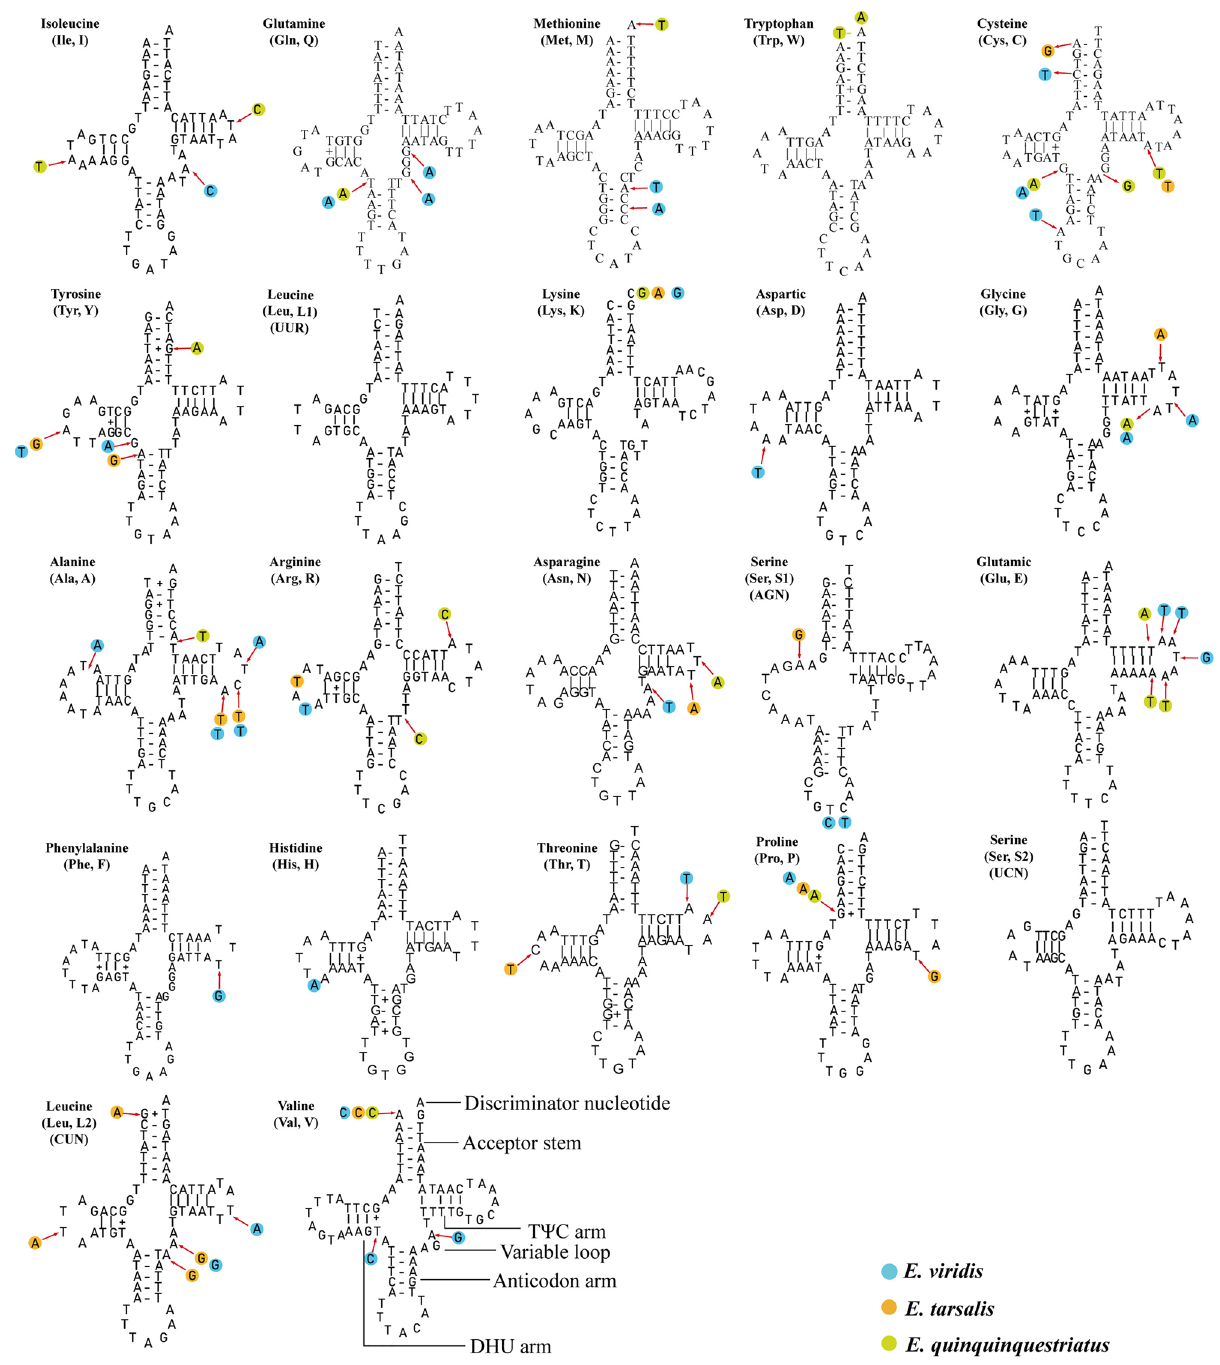
Figure 4. Predicted secondary cloverleaf structure for tRNA of four Eristalinus species. ( A ) Isoleucine, ( B ) Glutamine, ( C ) Methionine, ( D ) Tryptophan, ( E ) Cysteine, ( F ) Tyrosine, ( G , U ) Leucine, ( H ) Lysine, ( I ) Aspartic, ( J ) Glycine, ( K ) Alanine, ( L ) Arginine, ( M ) Asparagine, ( N , T ) Serine, ( O ) Glutamic, ( P ) Phenylalanine, ( Q ) Histidine, ( R ) Threonine, ( S ) Proline, ( V ) Valine. Arrows indicate variations of each site in four species of Eristalinus . Each species is marked by unique color (see color legend). The image was predicted by ARWEN version 1.2 (http:// 130. 235. 244. 92/ bcgi/ arwen. cgi) and tRNAscan-SE version 1.21 (http:// lowel ab. ucsc. edu/ tRNAs can- SE), drawing with Adobe Illustrator